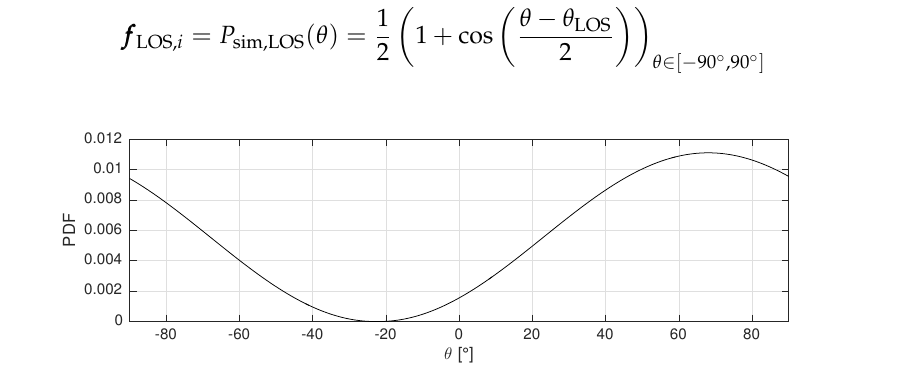
Figure 7. LOS fingerprint example: fff LOS, i for θ LOS = 68 ◦